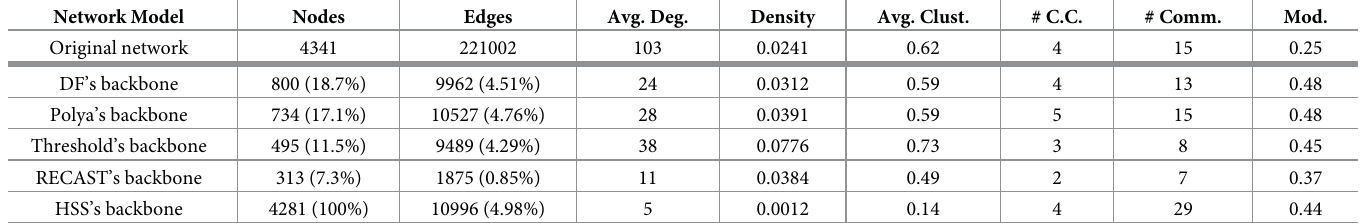
Table 4. Coordinated behavior on WhatsApp: Topological metrics of the network and backbones extracted by each candidate method (Columns 2-3 contain total numbers for the original network and also corresponding percentages for backbones). Network Model